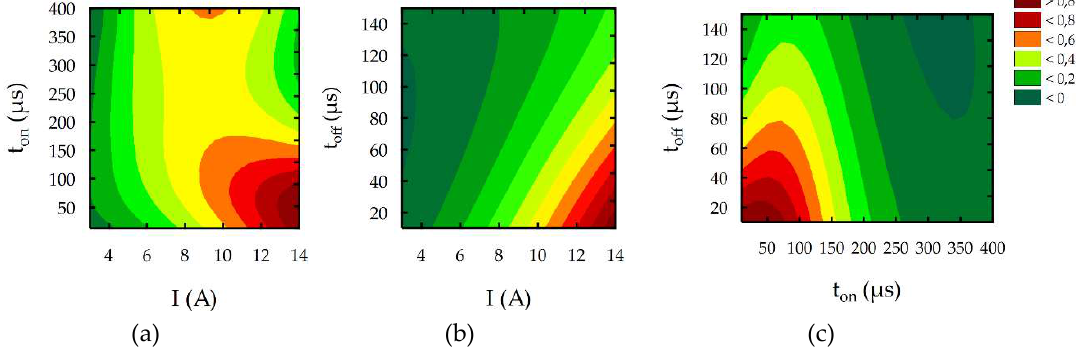
Figure 20. The contour plots of the desirability function for semi-finishing EDM optimization.